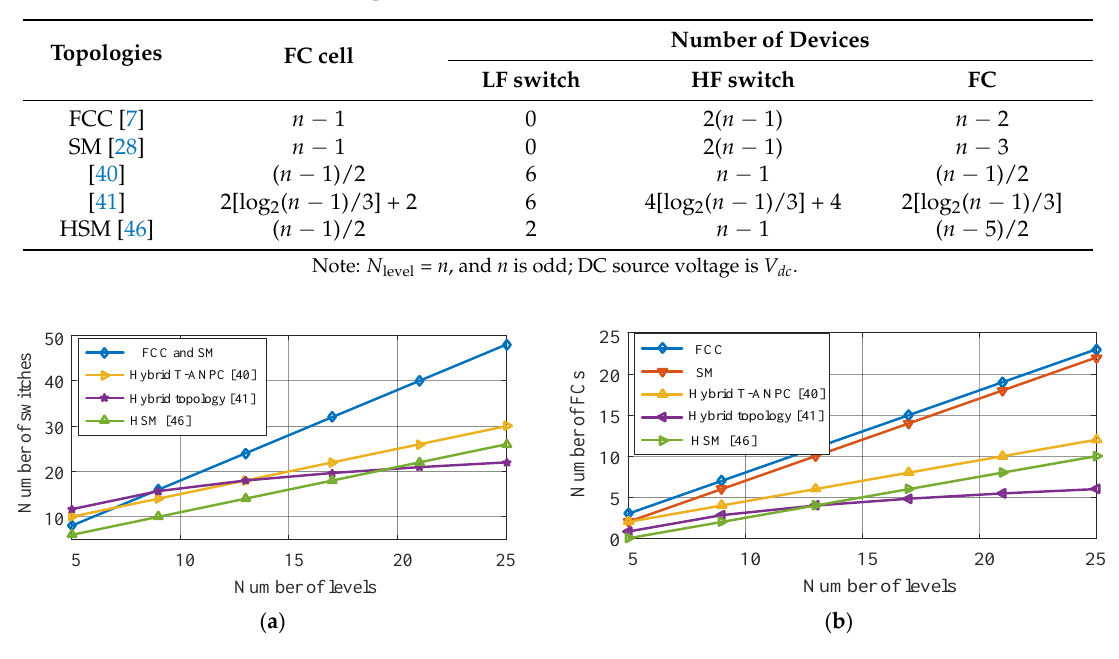
Figure 22. Comparisons of devices among FCs-based multilevel converters. ( a ) Number of switches, ( b ) number of FCs. Table 5. Performance summary of multilevel converters.